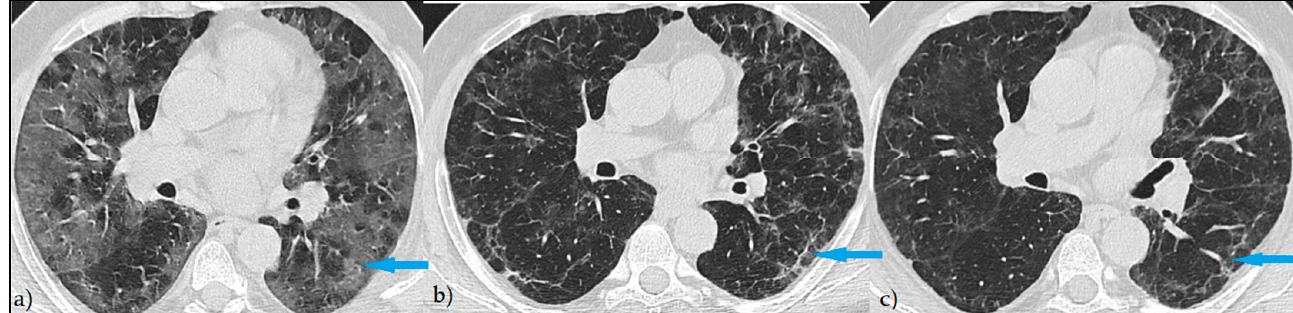
Figure 2. HRCT pattern of complete remission—Axial HRCT images: ( a ) minimal focal areas of GGO at the onset of the symptoms (blue arrow); ( b ) consolidation with a reticular pattern at 14 days from diagnostic (blue arrow); ( c ) complete remission of the lesions at 3 months.